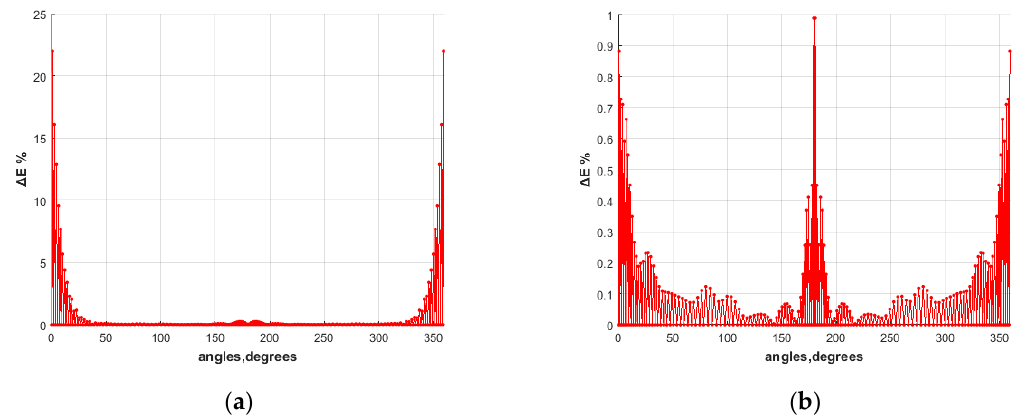
Figure 5. Plots of E field boundary condition error for a perfectly electric conducting (PEC) scatterer with initial ρ aux = ρ − 0.075 λ using: ( a ) the standard, conformal auxiliary surface; and ( b ) the deformed auxiliary surface.